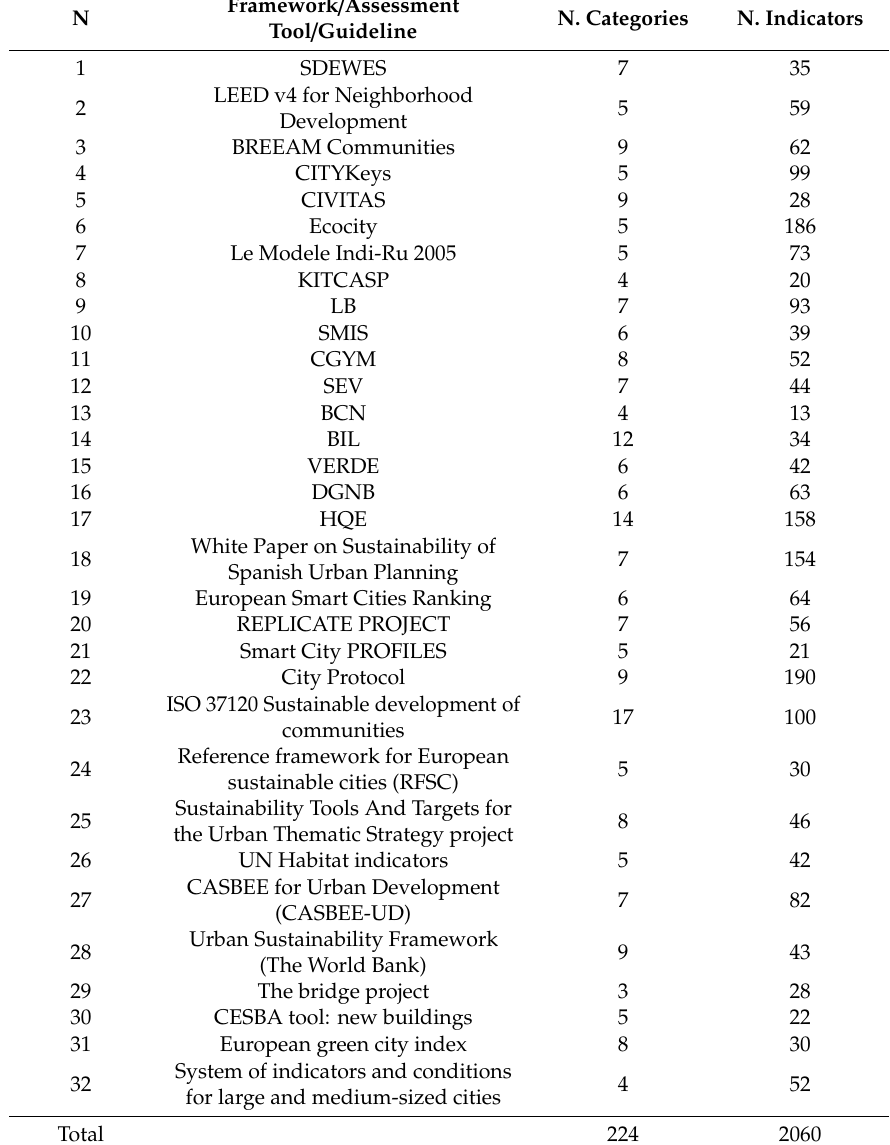
Table 1. Frameworks, Assessment Tools and Guidelines object of